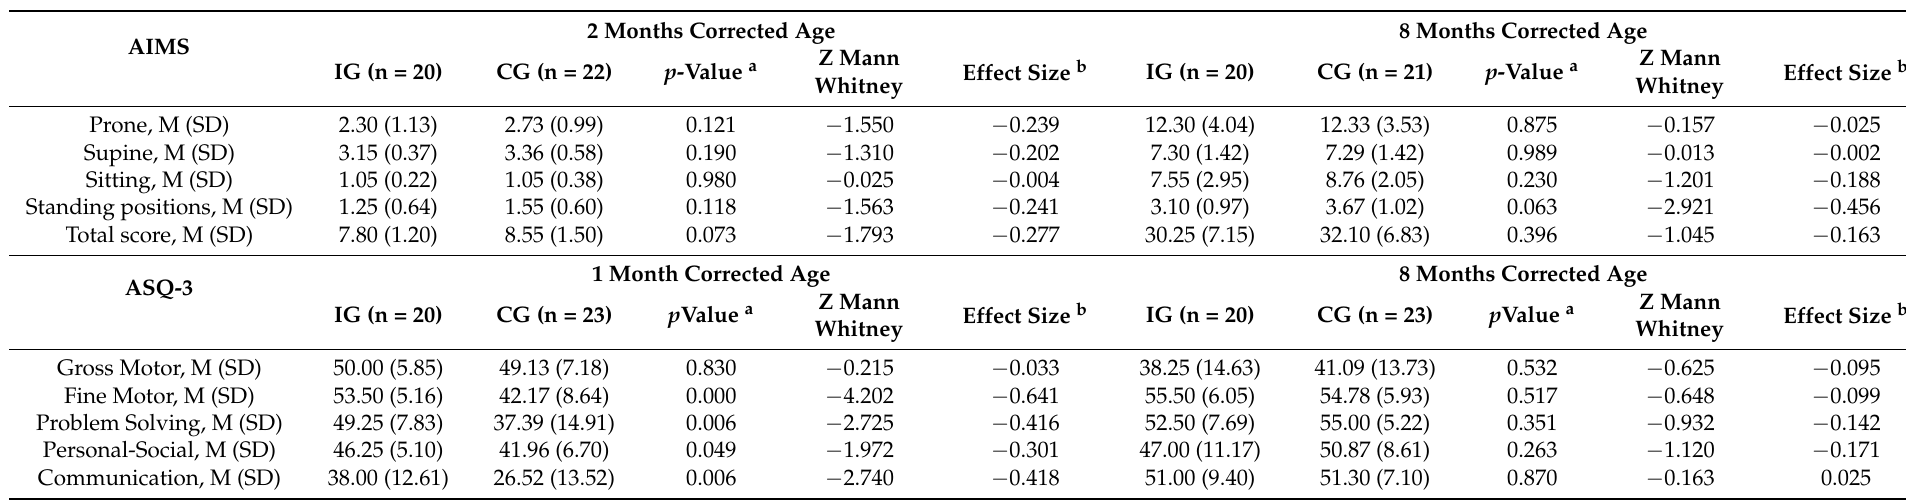
Table 3. Alberta Infant Motor Scale (AIMS) at 2- and 8-months corrected age, and Ages and Stages Questionnaire—Version 3 (ASQ-3) at 1- and 8-months of corrected age in the intervention group (IG) and control group